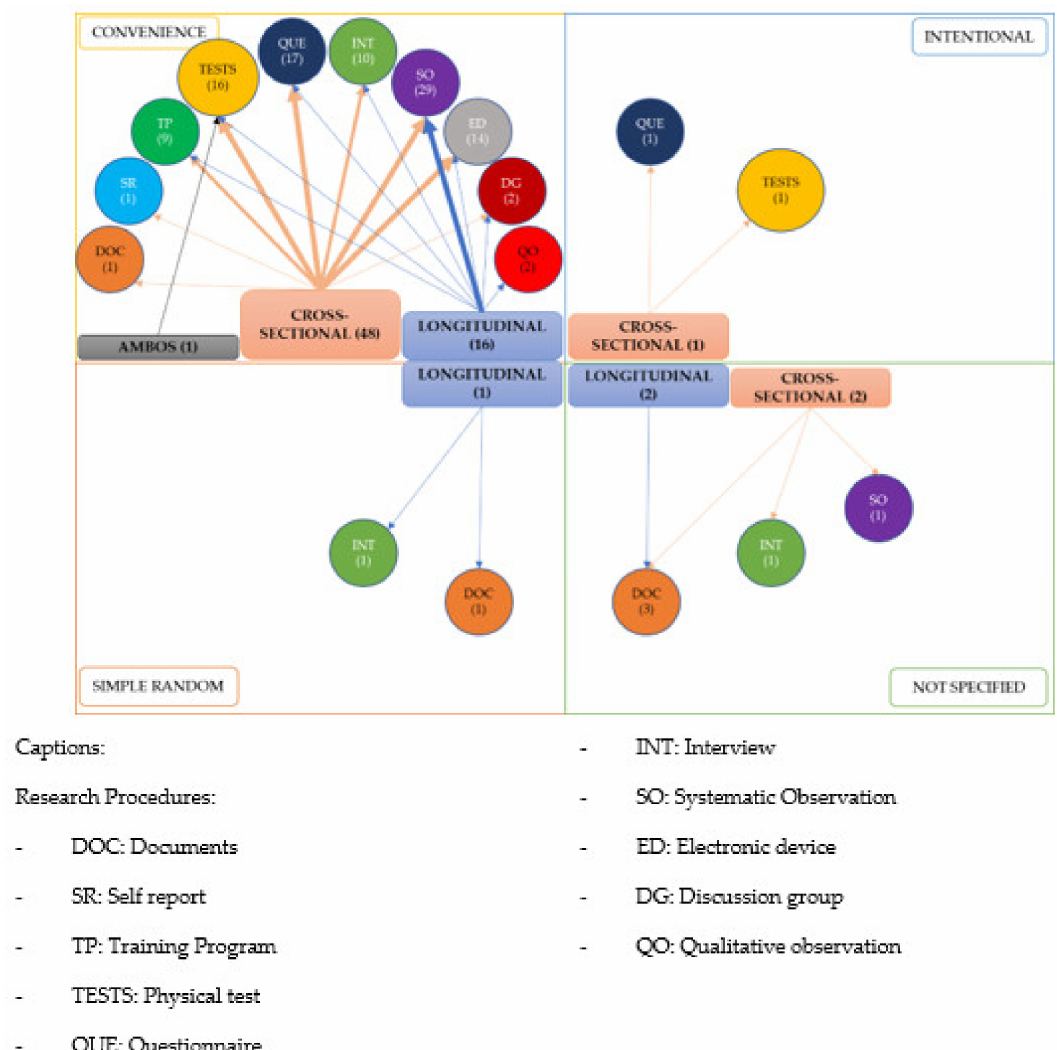
Figure 7. Cross-matching of research